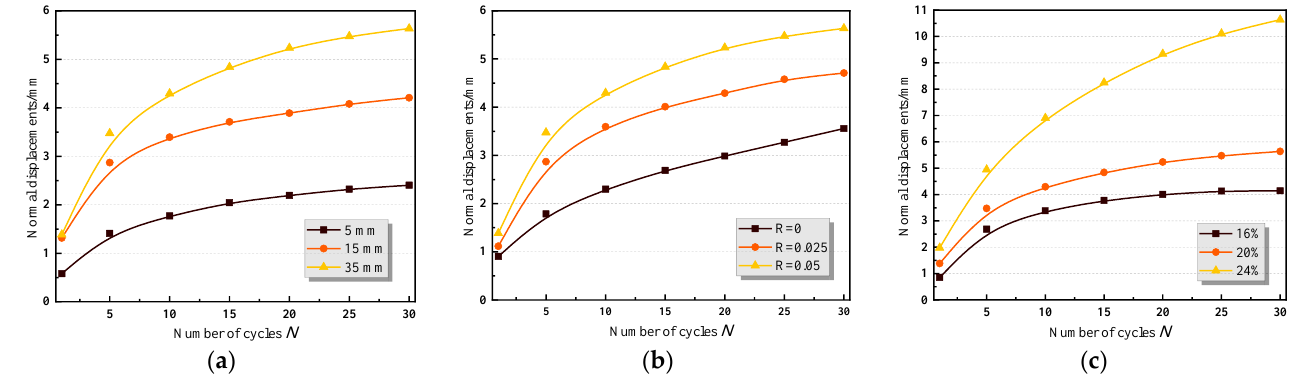
Figure 12. Curve for normal displacement – number of cycles under different conditions : ( a ) shear amplitude; ( b ) roughness; ( c ) water content.